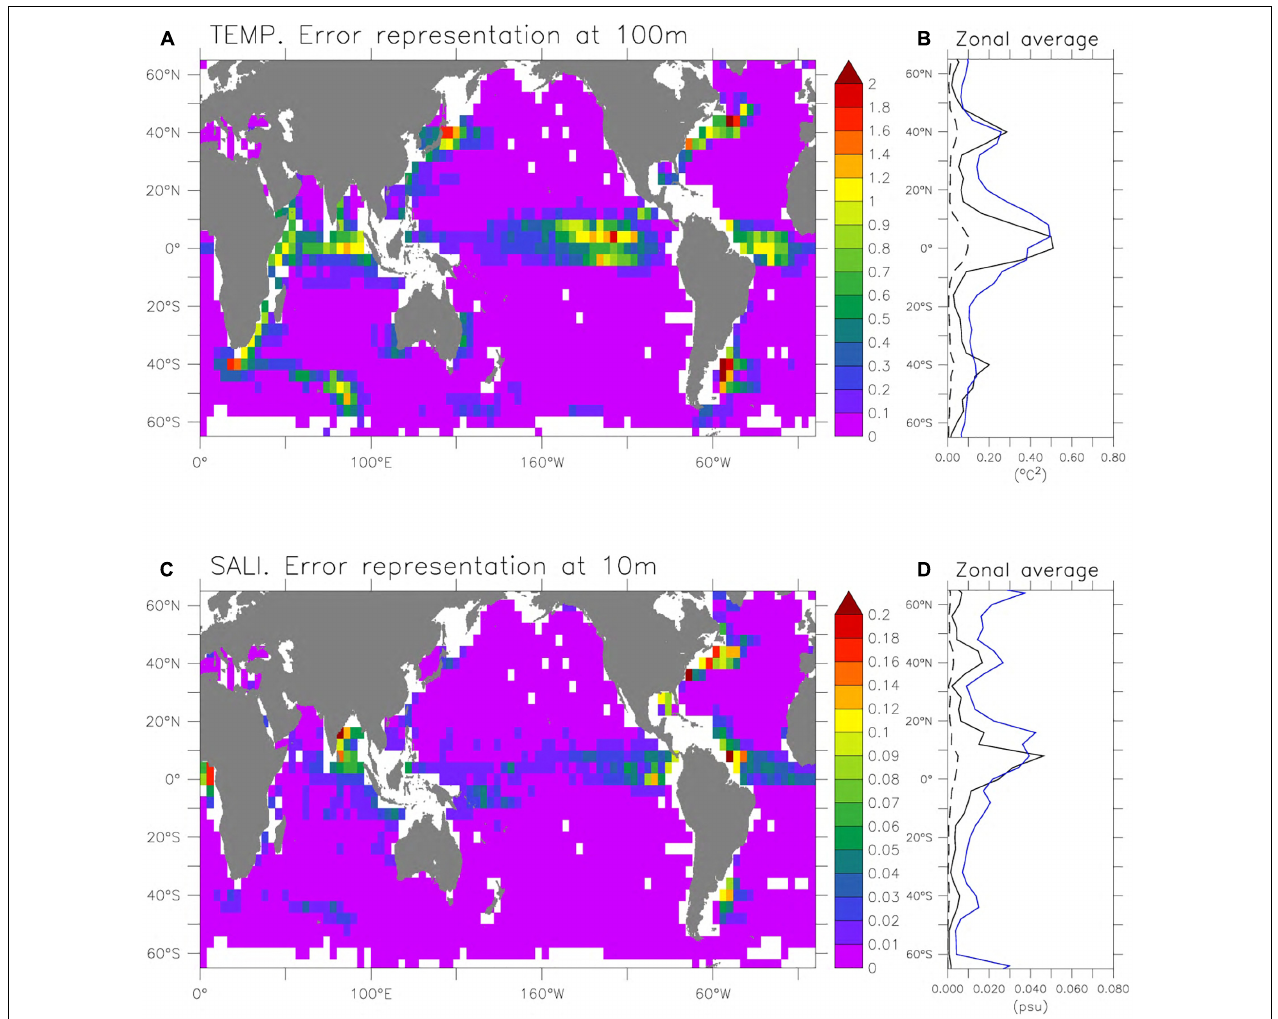
FIGURE 3 | Total error variance on synthetic observations per 4 ◦ × 4 ◦ box for (A,B) the 100-m temperature and (C,D) the 10-m salinity, based on differences between the synthetic observations of the Argo-1x design and its equivalent Nature Run values. In (B,D) , the zonal averages of (A) and (C) (full black lines) are compared with the error variance based on pairs of differences between synthetic observations extracted from the 1/12 fields, with and without spatial smoothing to fit the 1/4 grid (dashed black lines), and from the operational representation error used in the 1/4 ◦ MOI system (blue lines, Lellouche et al.,